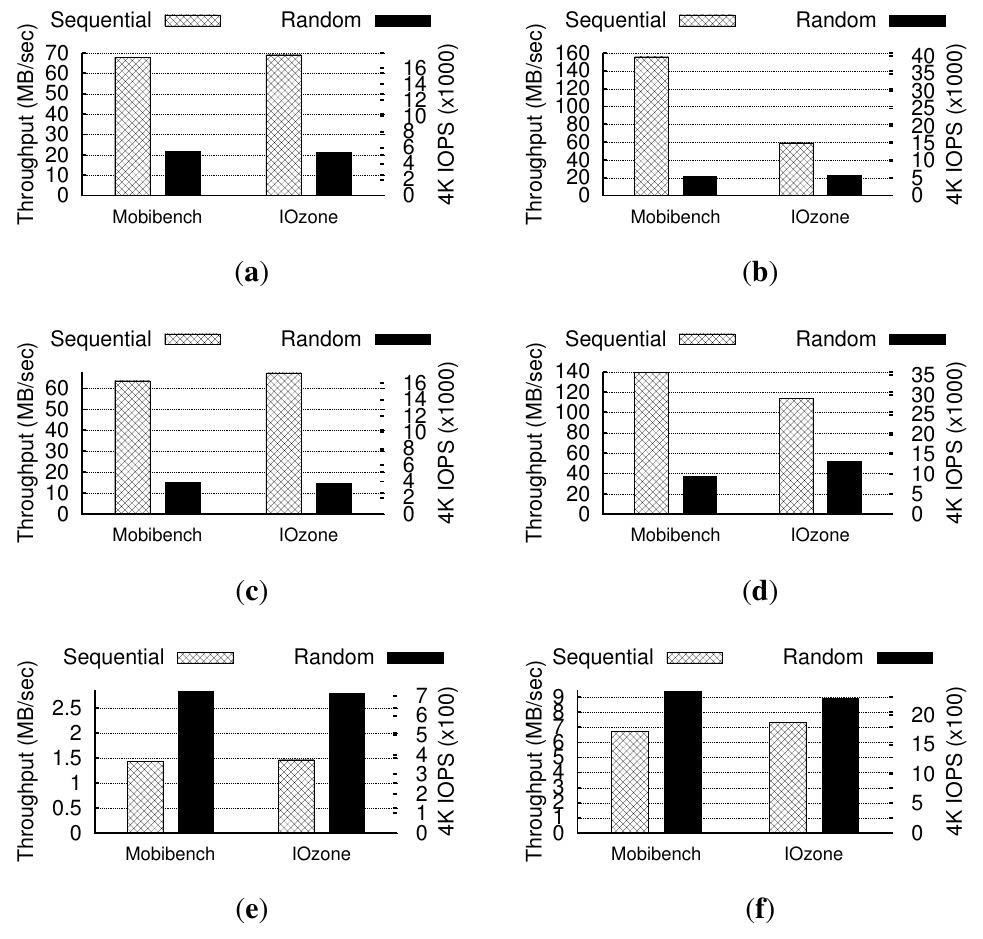
Figure 7. Mobibench vs . IOzone, I/O on internal eMMC. ( a ) Buffered write; ( b )